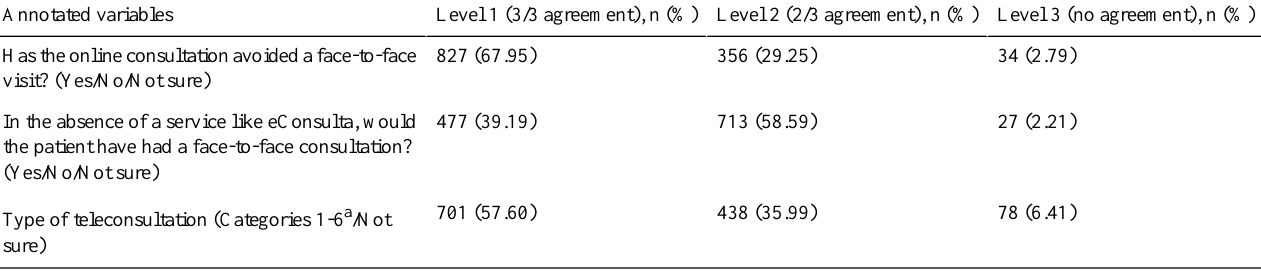
Table 3. Consensus among three annotators for annotated conversations